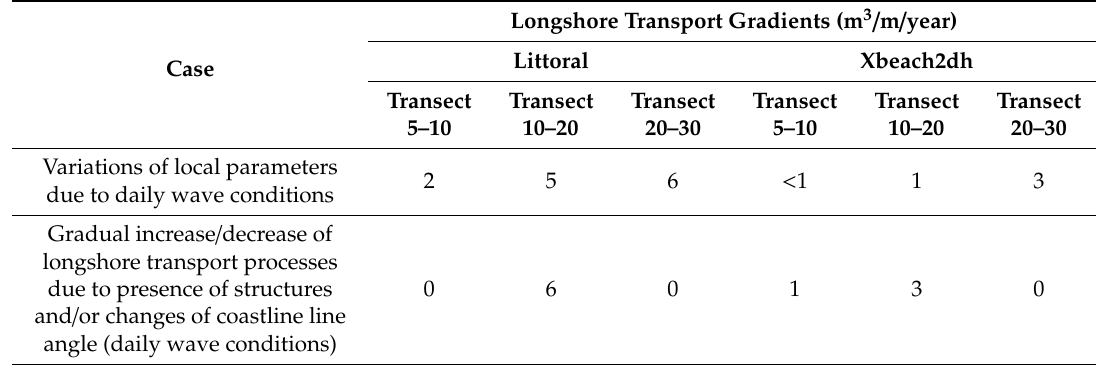
Table 6. Longshore transport gradients in beach zone for daily wave conditions; d 50 = 0.4